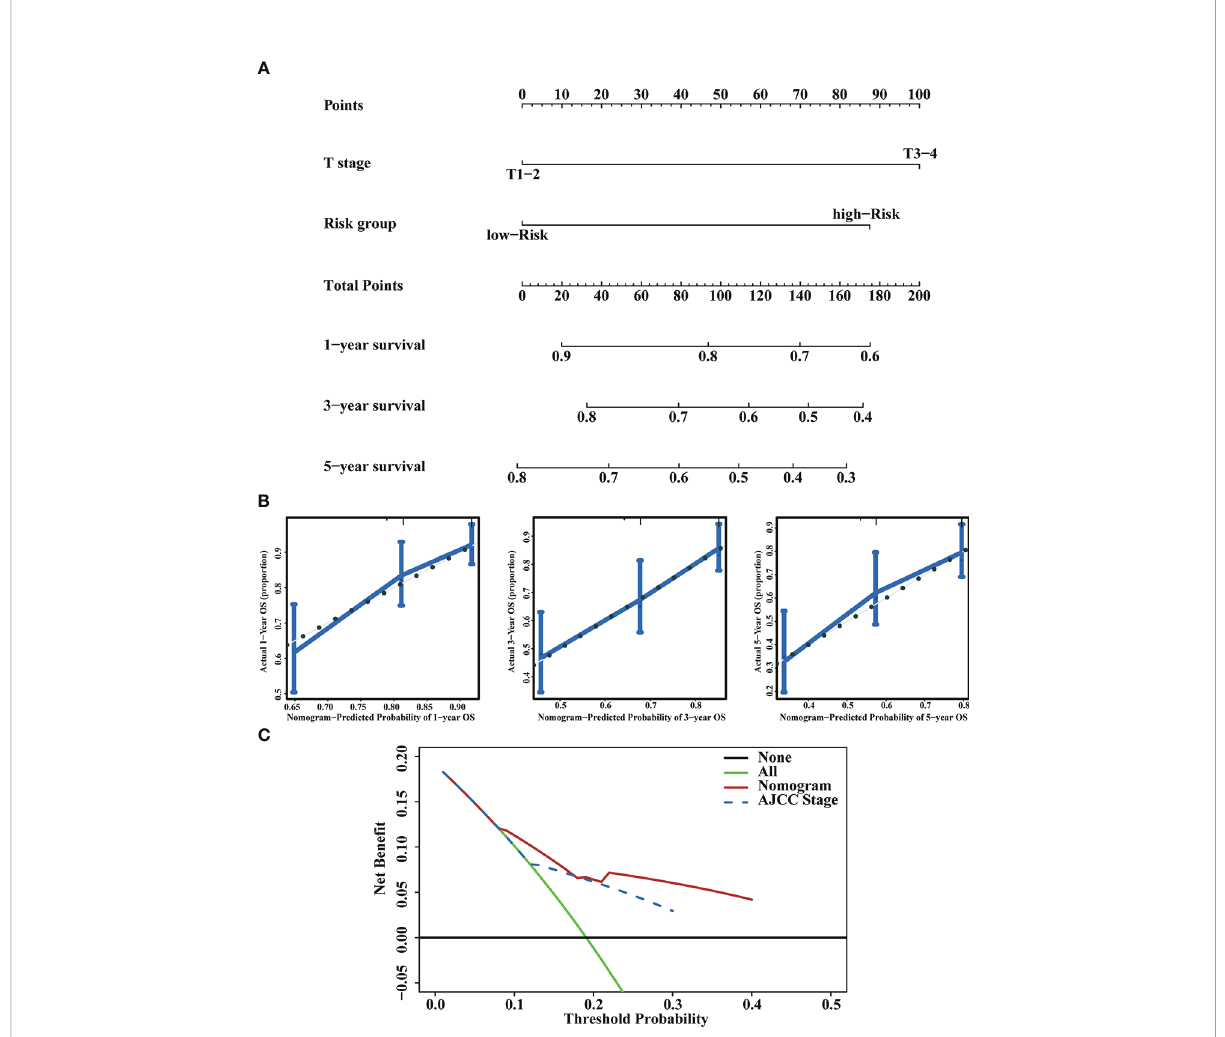
FIGURE 5 Prognostic nomogram construction. (A) Nomogram integrating the RS and T stage. (B) Calibration curves for predicting 1,3 and 5 years OS. (C) DCA of the nomogram and AJCC